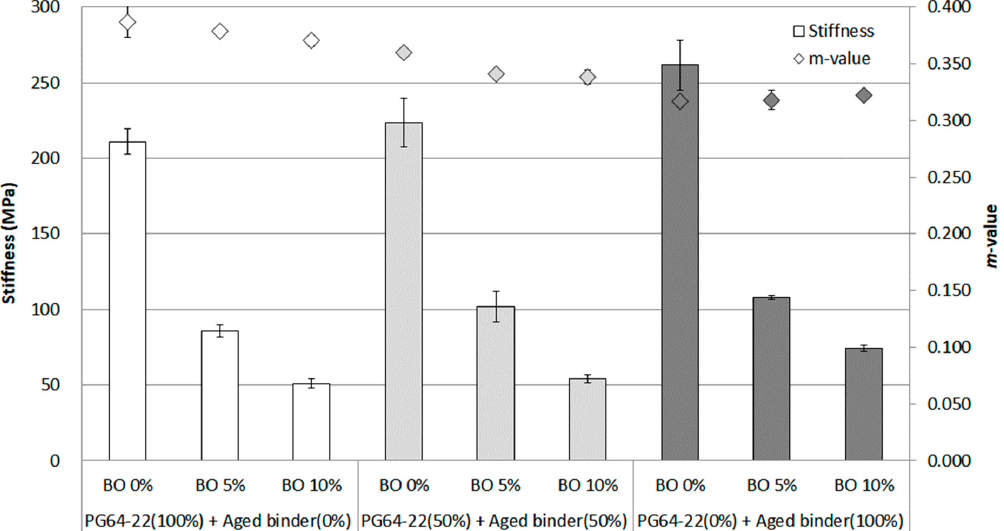
Figure 8. Stiffness and m -value of each asphalt binder containing the base oil for RTFO + PAV